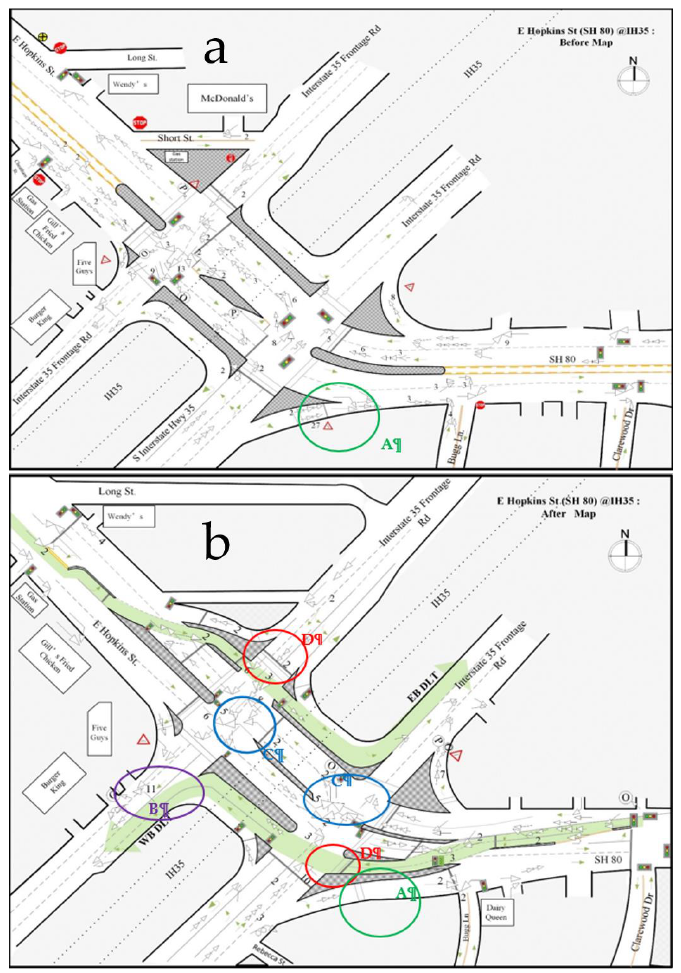
Figure 4. Collision diagrams at Intersection 2 SH 80 (Hopkins Street) at IH 35. Collision diagram-based analysis. ( a ) Collision diagrams before the implementation of DLT. ( b ) Collision diagrams after the implementation of DLT.